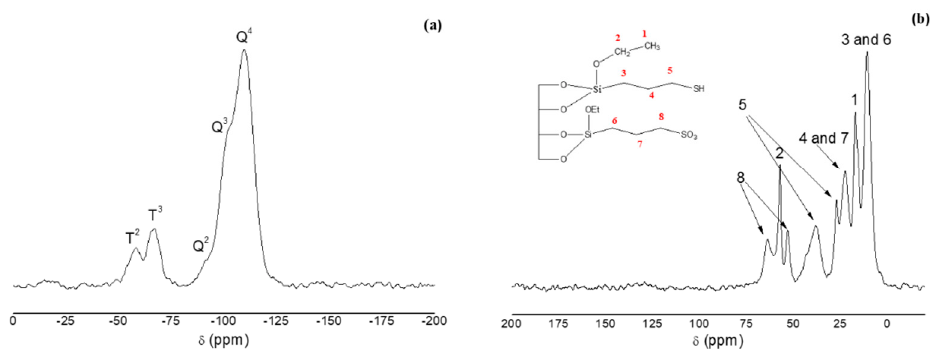
Figure 3. ( a ) 29 Si PDA-MAS-NMR and ( b ) 13 C CP-MAS-NMR spectra of H-SBA-15-SO 3 −